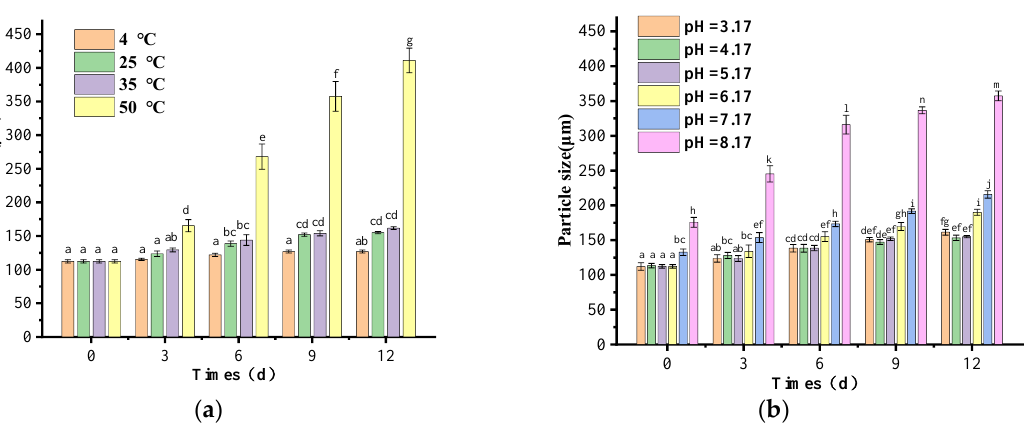
Figure 12. Changes in particle size of SLN-CA at different pH ( b ) and temperature ( a ) for 12 days. Error bars show the standard deviation of the means (three replications); different letters a – m in the graph indicate significant differences between treatments based on Duncan ’ s multiple range test ( p < 0.05).